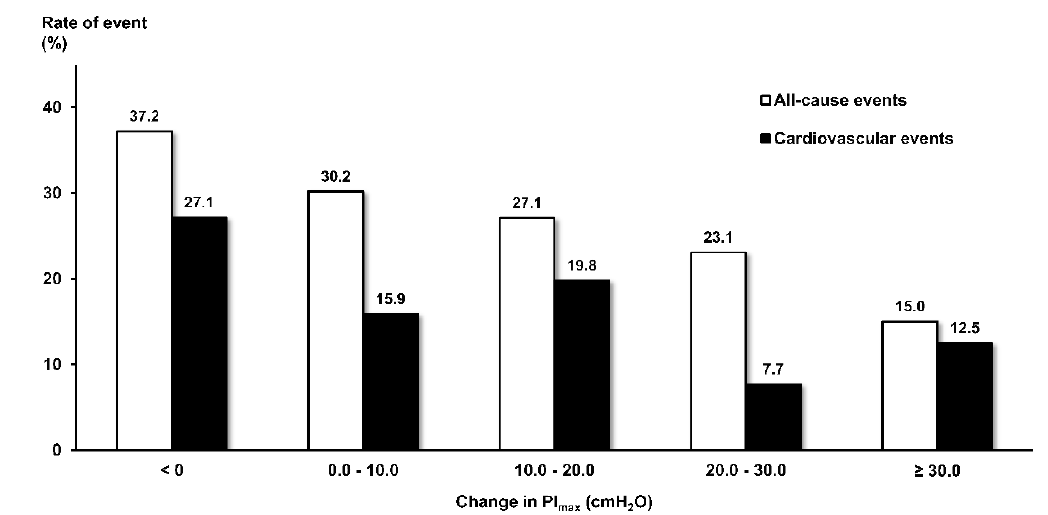
Figure 4. Unadjusted rates of all-cause clinical events and cardiovascular events according to categories of change in PI max per 10 cmH 2 O. White bars, all-cause events; black bars, cardiovascular events. PI max , maximal inspiratory pressure.